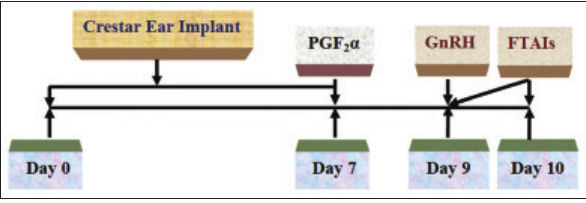
Figure-3: Norgestomet ear implant protocol of estrus